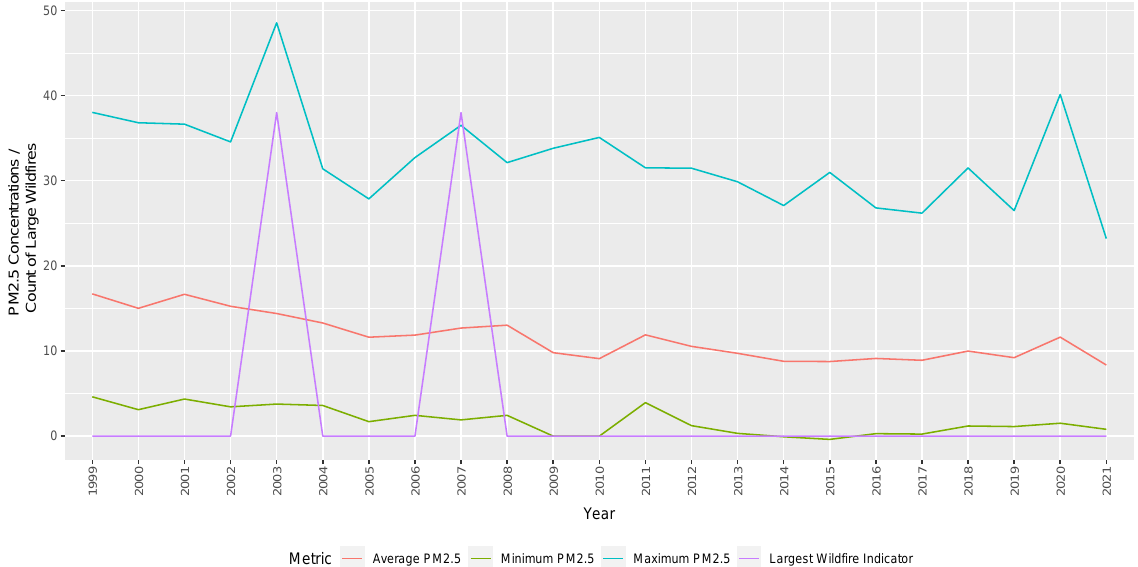
Figure 2. Relationship between PM2.5 concentration readings and wildfire events: San Diego County